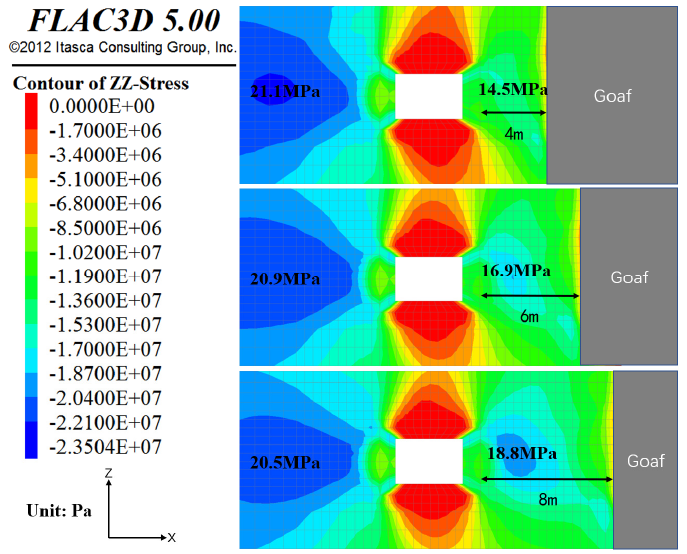
Figure 11. Vertical stress distribution in surrounding rock of yield pillar widths of 4 m, 6 m, and 8